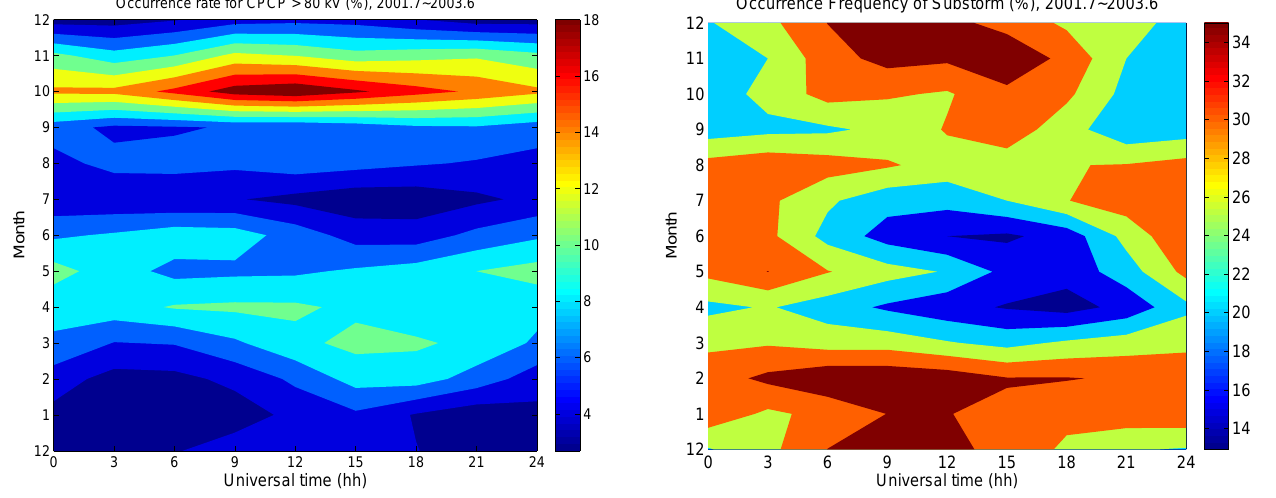
Fig. 2. Same format as Fig. 1, but for occurrence rate of CPCP > 80kV.